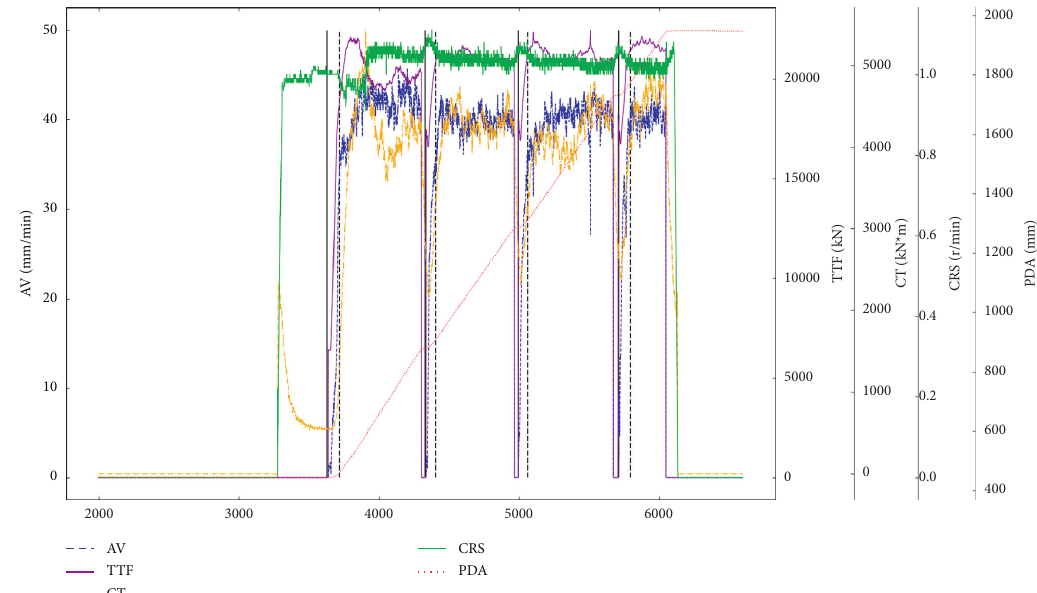
Figure 5: Segmentation results of construction data in ring 552 of hui-shang section, line 4 of zhengzhou.